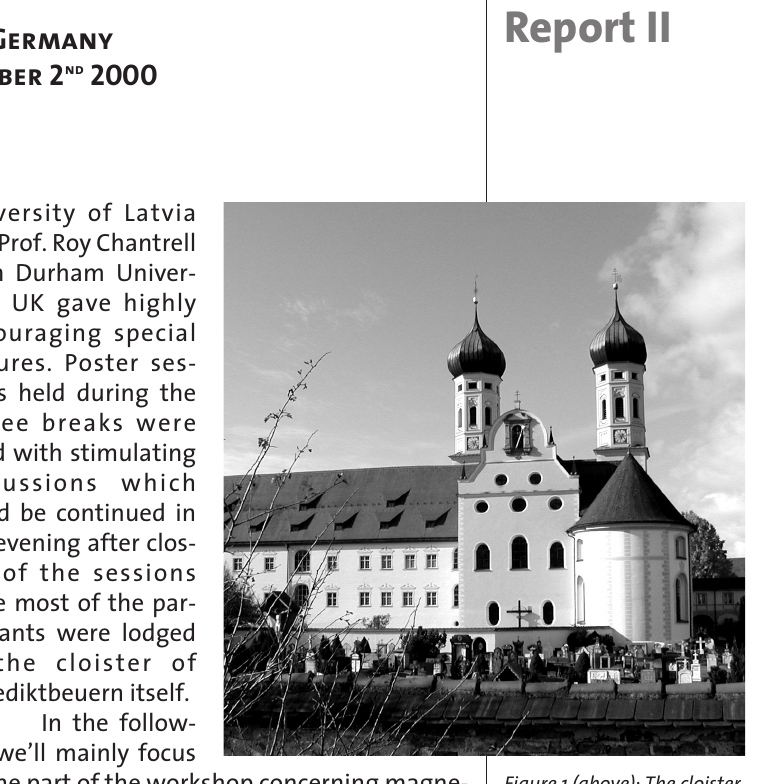
Figure 1 (above): The cloister of Benediktbeuern – venue of the 3rd German Ferroflu- id Workshop. Figure 2 (bottom): One of the exhibits of the arts exhibition. “No title” by Ilona Kempny, photography and